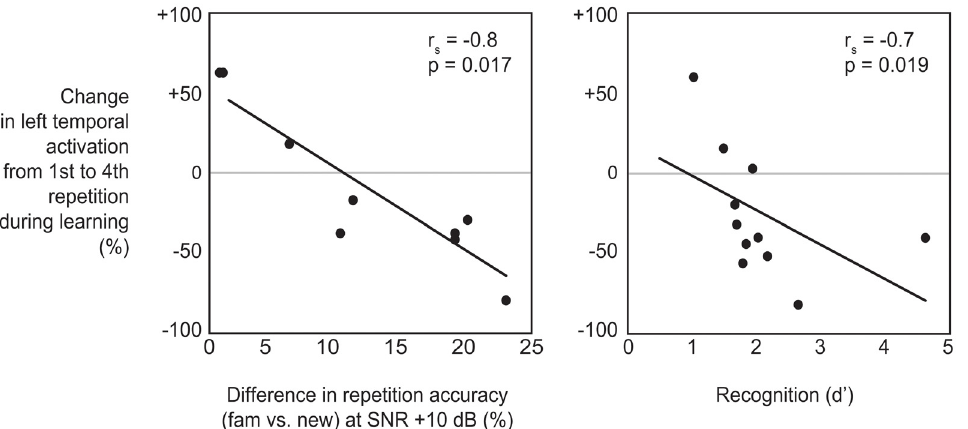
Fig 6. Significant correlations of neural effects and behavioral measures. Scatterplots of percent change of the left temporal activation from the 1 st to the 4 th repetition during learning as a function of percent difference in repetition accuracy between new and familiar word forms at SNR +10 dB ( left ) and as a function of recognition measure d ’ ( right